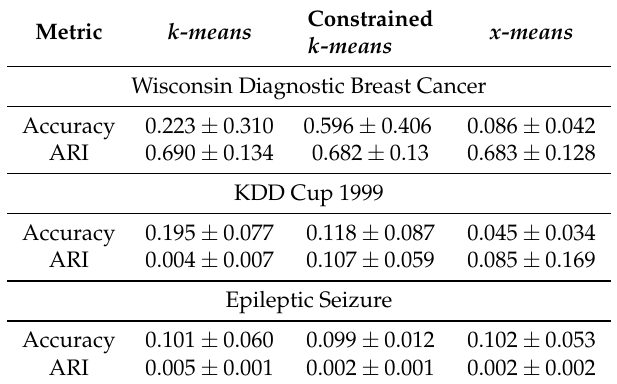
Table 4. Comparison of different algorithms addressing initialization issue.